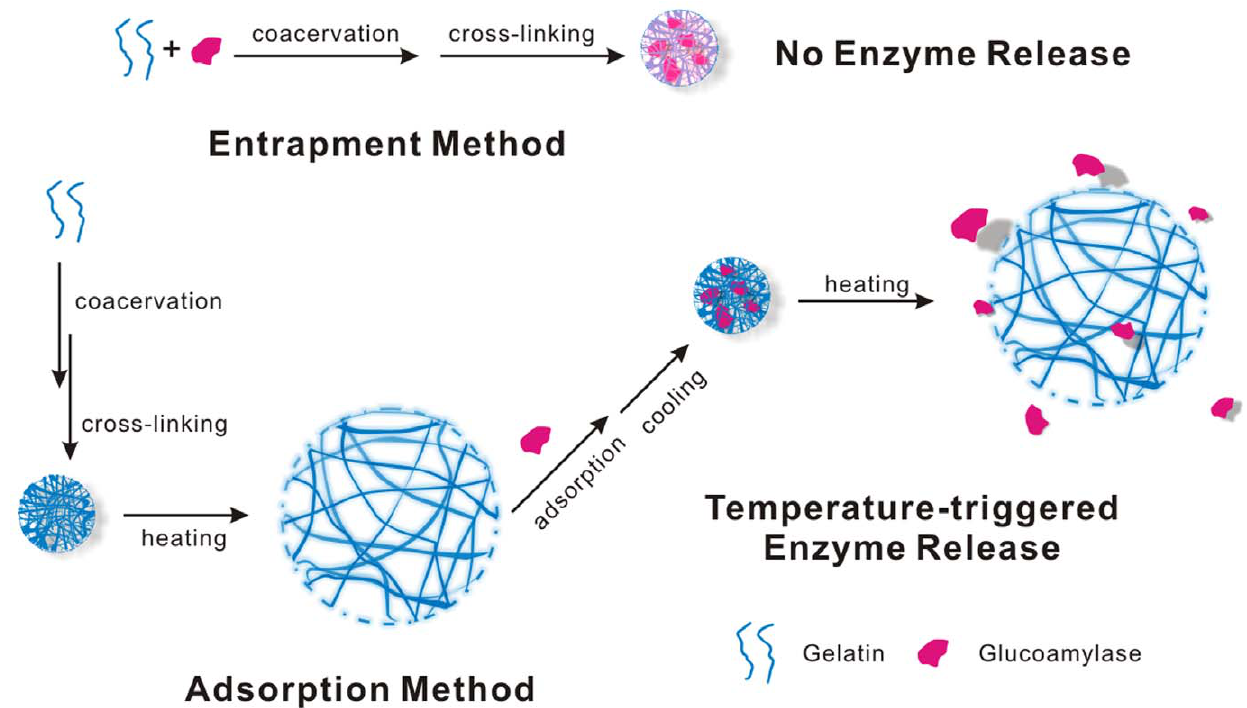
Figure 1. Schematic illustrations for the preparation of CLGNs, glucoamylase immobilization, and temperature-triggered enzyme release. The gelatin and glucoamylase were mixed together before the cross-linking step in the entrapment method. In the adsorption method, the enzyme was adsorbed after the formation of the CLGNs.